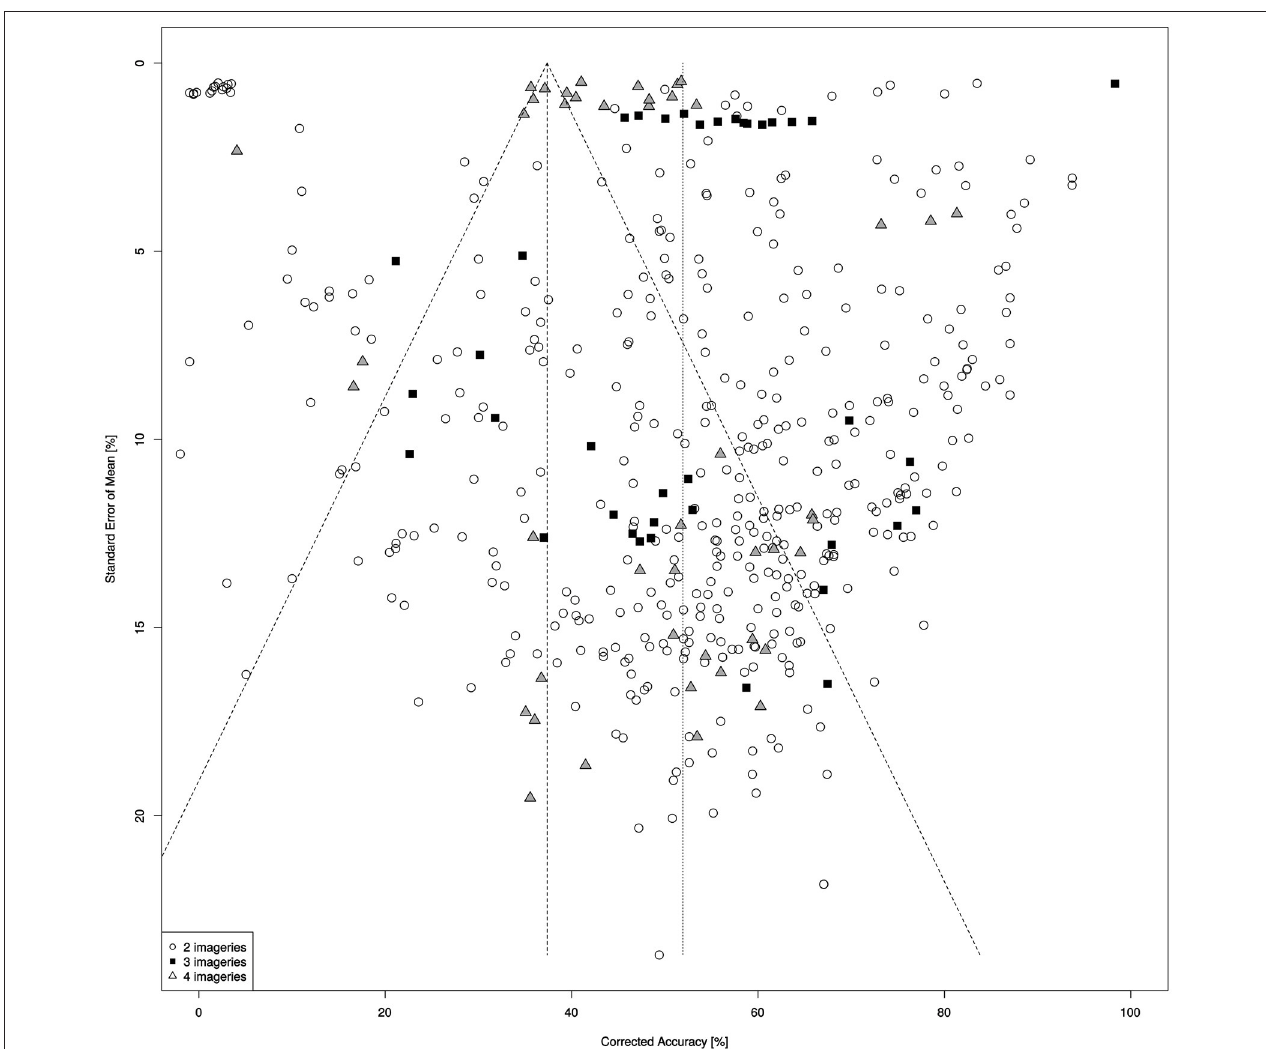
FIGURE 3 | Funnel plot for different types of